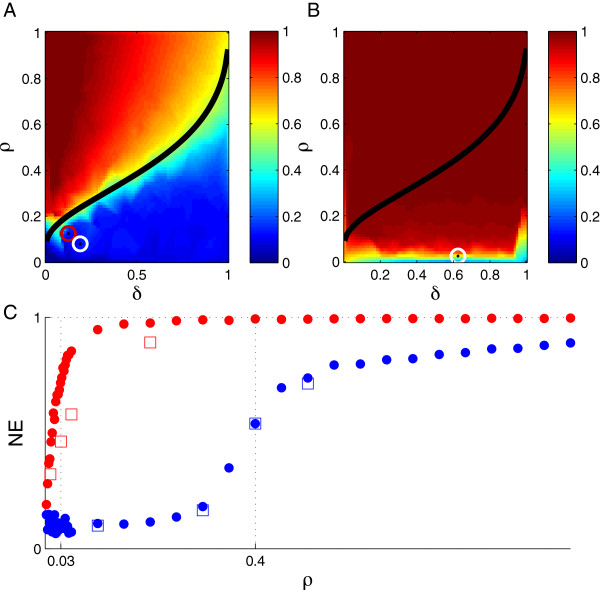
Error in the ρ − δ plane for a measurement matrix of random genomic SNPs (ρ=sn and δ=np). (A) Color corresponds to the normalized error (NE) of the coefficients x−x^L2xL2. The black curve is the expected phase boundary between poor and good recovery from [26]. The number of SNPs, p, was fixed at 8,027. The heritability was set to one (noiseless case). The circles correspond to the points (ρ = 0.08, δ = 0.19) (white) and (ρ = 0.125, δ = 0.125) (red) discussed in Measures of selection. (B) Same as panel (A), except that the heritability was set to 0.5 (noisy case). The white circle corresponds to the point (ρ = 0.025, δ = 0.625) discussed in Measures of selection. (C)NE versus ρ for fixed n = 4,000 and p = 8,027 (blue corresponds to h2 = 1, red to h2 = 0.5). The square markers indicate recovery quality evaluated at a few data points using the lasso algorithm with 10-fold cross-validation written by MATLAB.